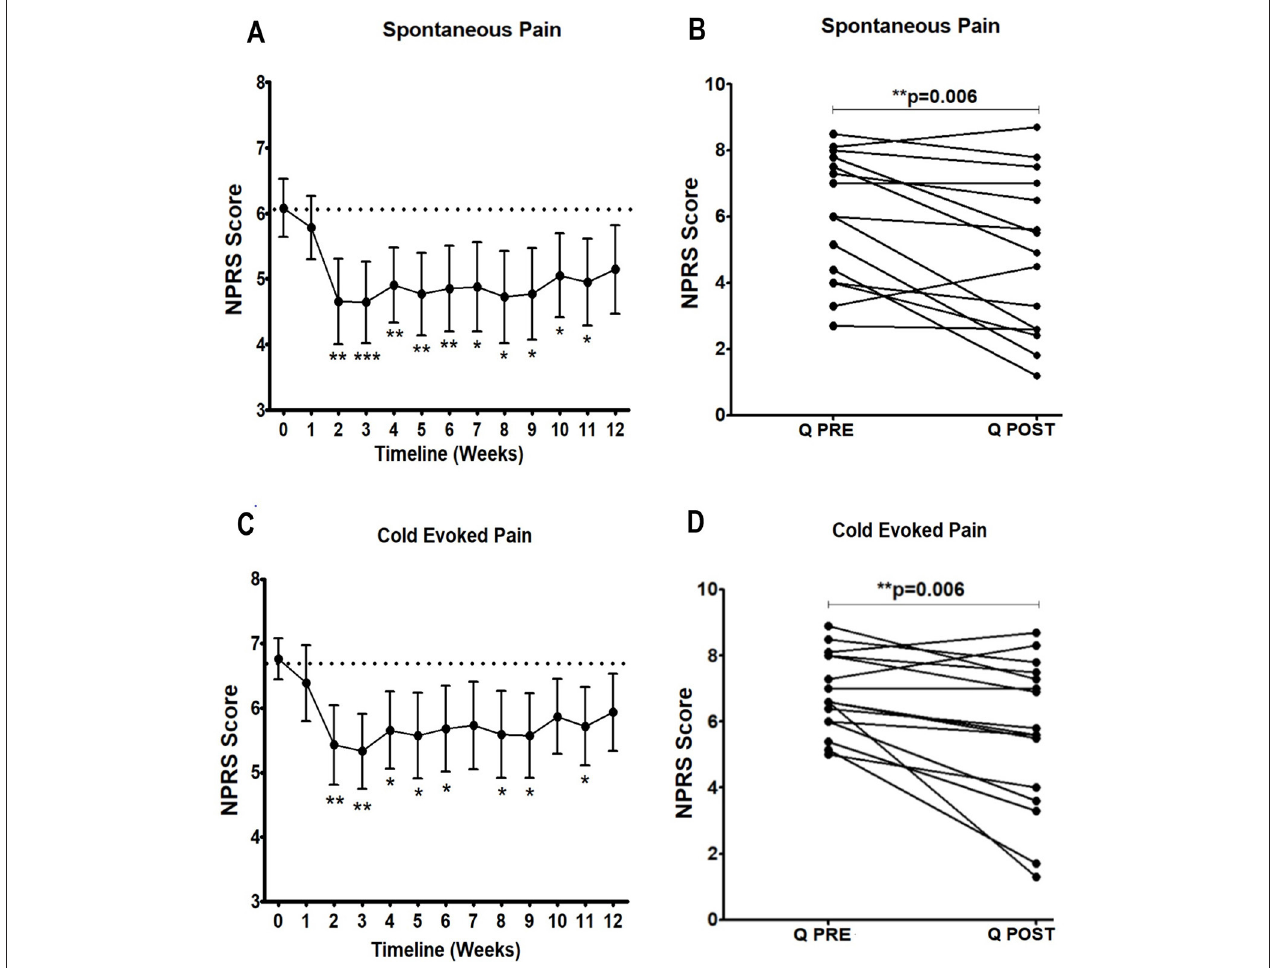
FIGURE 1 | Time-course of pain relief in participants with NFCI treated with Capsaicin 8% patch. Time-course of pain scores for spontaneous pain (A, B) and cold evoked pain (C, D) . Repeated measures ANOVA for baseline to week 12 period was statistically significant for spontaneous pain ( F = 2.4; ** p = 0.005); and cold evoked pain ( F = 2.1; * p = 0.01); statistically significant difference was observed for the overall pain scores 3 months after the treatment (paired t test, B and D ). 95% CI shown for spontaneous pain weekly (A, C) , and p values, with Dunnett’s Multiple Comparison Test (for a significance level of